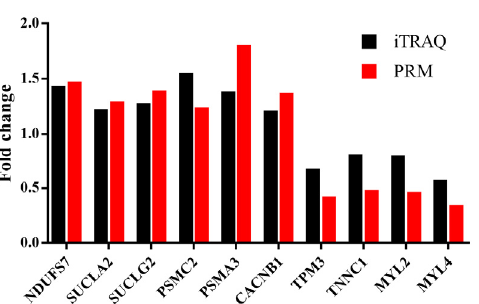
Figure 6. Verification of iTRAQ DAPs by using PRM analysis. NDUFS7, NADH: ubiquinone oxidoreductase core subunit S7; SUCLA2, Succinate-CoA ligase, ADP-forming, subunit beta, mitochondrial; SUCLG2, Succinate-CoA ligase, GDP-forming, subunit beta, mitochondrial; PSMC2, Proteasome 26S subunit, ATPase 2; PSMA3, Proteasome subunit alpha type; CACNB1, Calcium voltage-gated channel auxiliary subunit beta 1; TPM3, Tropomyosin 3; TNNC1, Troponin C1, slow skeletal and cardiac type; MYL2 and MYL4, Myosin light chain 2 and 4. iTRAQ: isobaric tags for relative and absolute quantitation; PRM: parallel reaction monitoring.